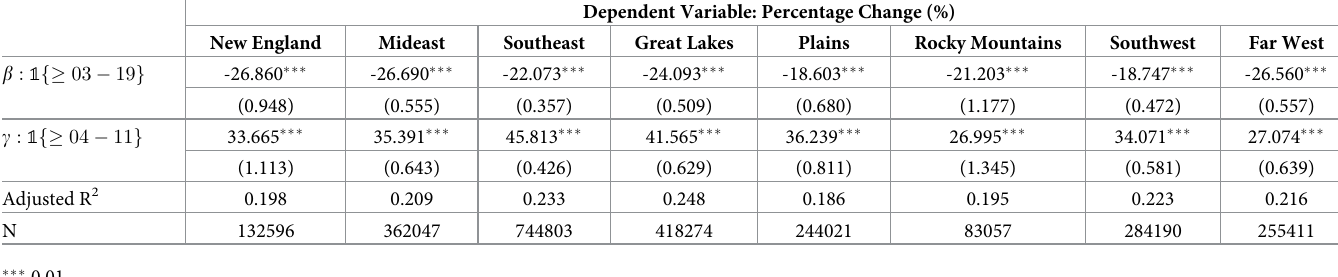
Table 4. Effects of initial lockdown and stimulus payments on percentage change across geographic